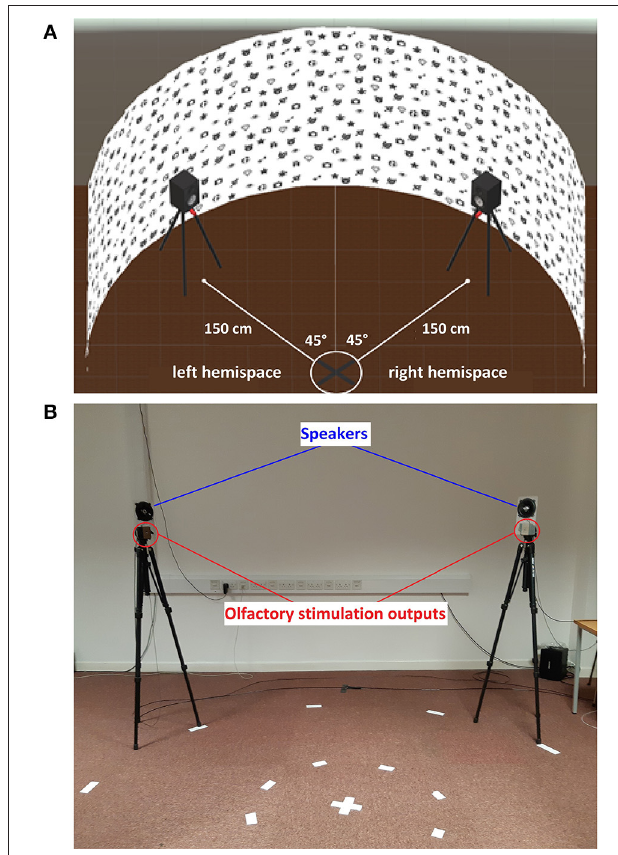
FIGURE 5 | Schematic representation of the VR environment. (A) The curved white virtual wall used to implement the Bells test inside the VR headset. (B) The real world location of the olfactory (red) and auditory (blue) stimulation outputs integrated on top of a